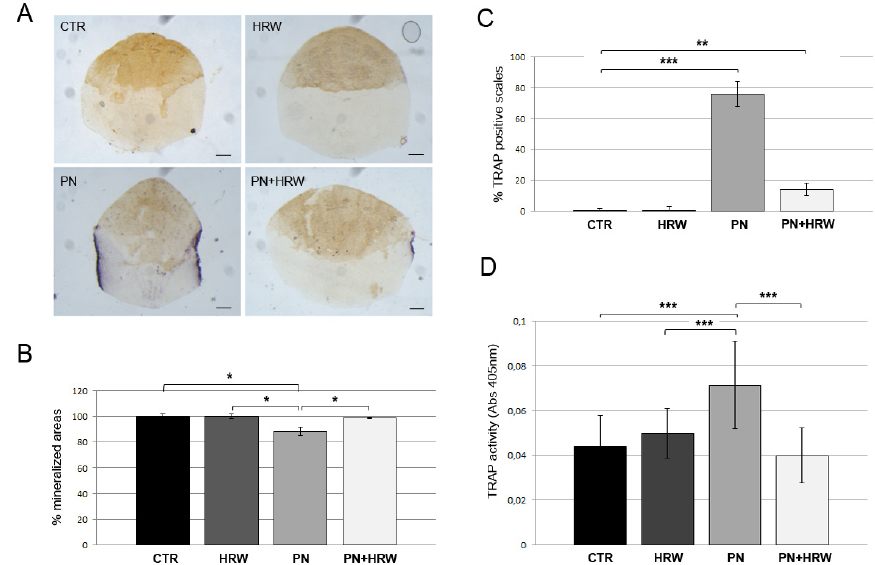
Figure 3. ( A ) Histological TRAP activity assay highlighted by violet staining of enzymatic activity along the scale borders of PN and PN + HRW scales. Scale bar 0.22 mm. ( B ) Percentage of miner- alized area of scales with PN scales area reduced by 11.8% (PN vs CTR, p < 0.05 *; PN vs HRW, p < 0.05 *; PN vs PN+HRW, p < 0.05 *). ( C ) Percentage of TRAP positive scales equal to 76% in PN fish and 14% in PN + HRW fish (CTR vs PN, p < 0.001 ***; CTR vs PN+HRW, p < 0.01 **). ( D ) Biochemical TRAP assay shows increased TRAP levels only in PN fish scales (PN vs CTR, p < 0.001 ***; PN vs HRW, p < 0.001 ***; PN vs PN+HRW, p < 0.001 ***).